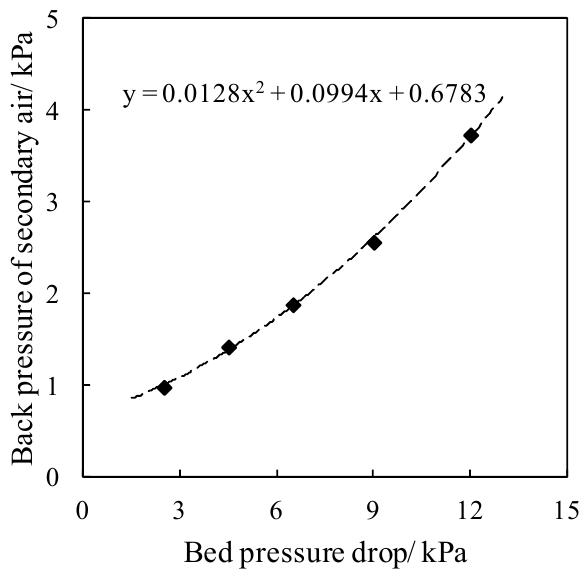
Figure 10. Change in secondary air back pressure with bed pressure drop.